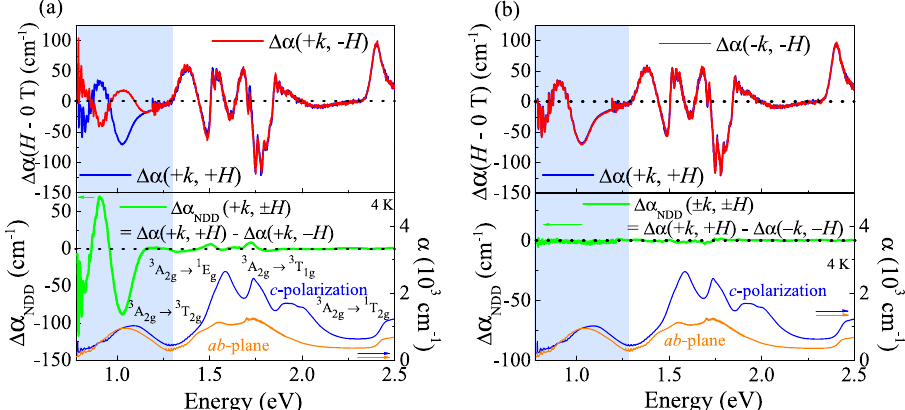
Fig. 1 Illustrating symmetry considerations for nonreciprocity in Ni 3 TeO 6 . a Full fi eld absorption difference spectra of Ni 3 TeO 6 as a function of energy for the ( + k , + H ) and ( + k , − H ) con fi gurations in the toroidal measurement geometry. For illustration purposes, we employ H = 60 T. Nonreciprocal directional dichroism is shown in green. Here, Δ α NDD ( + k , ± H ) = Δ α ( + k , + H ) – Δ α ( + k , − H ). Experimentally, it is common to reverse the magnetic fi eld direction as we have done here. Nonreciprocity can also be de fi ned in terms of counter-propagating beams, + H ), as shown in Fig. 2. b Full fi eld absorption difference spectra in the ( + k , + H ) and ( − k , − H ) con fi gurations. Notice that they are Δ α NDD (± k , the same. α NDD (± k , ± H ) = Δ α ( + k , + H ) – Δ α ( − k , − H ) (also shown in green) vanishes when both light propagation and magnetic fi eld direction are switched simultaneously. The absolute absorption spectrum is shown at the bottom of each panel to provide context. Note that we used cubic term symbols here ( 3 A 2g , 3 T 2g , 1 E g , 3 T 1g , 1 T 2g ) to denote Ni 2 + atomic multiplets because the deviation from cubic symmetry by trigonal distortion at the Ni sites is small ( ≈ 0.1 eV in terms of crystal fi